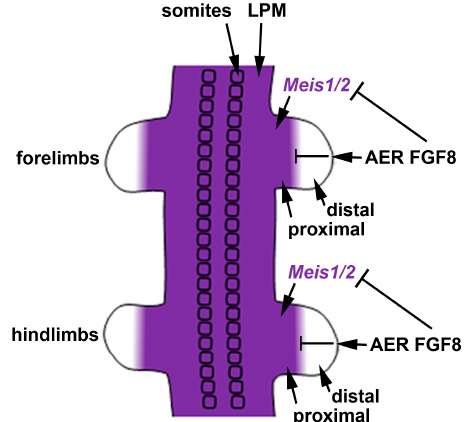
Figure 3. Role of Meis1/2 genes and FGF signaling in limb proximodistal patterning. In the E10.5 mouse embryo, Meis1/2 expression that already exists in trunk lateral plate mesoderm (LPM) prior to limb bud initiation extends into the proximal regions of both forelimbs and hindlimbs as they undergo outgrowth from the trunk. Meis1/2 expression in the trunk LPM and proximal limb does not require RA signaling; the factor(s) that activate Meis1/2 expression in trunk LPM and limb are unknown. A boundary of Meis1/2 expression is formed by distal FGF8 (and other FGFs) secreted by the apical ectodermal ridge (AER) that represses Meis1/2 to limit expression to a proximal limb